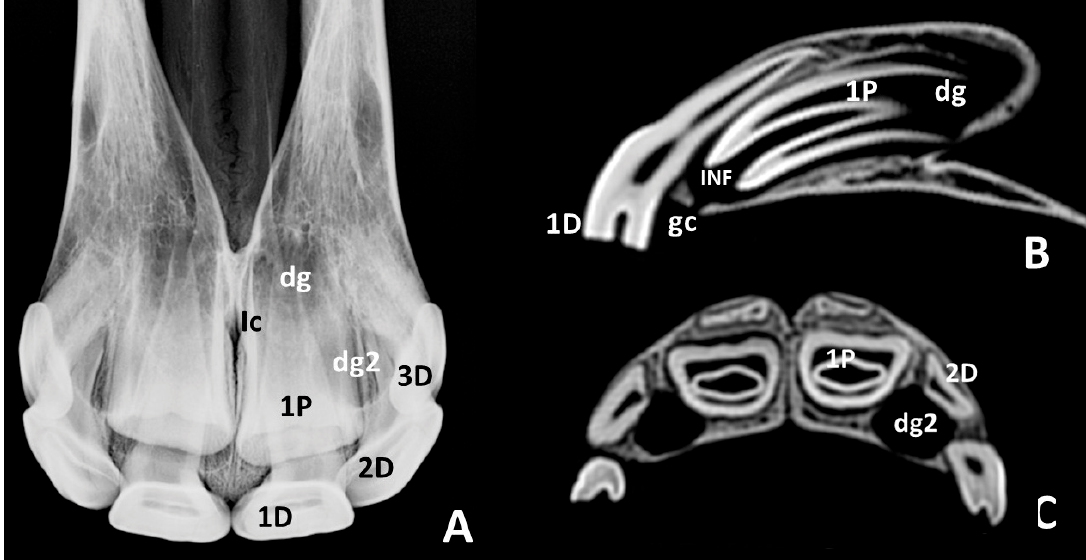
Figure 6. Intraoral radiographic images ( A ) and sagittal and transverse scans ( B , C ) of maxillary incisor arcade of one skull representative of group 1d. 1D , left 1st deciduous incisor—601; 2D , left 2nd deciduous incisor—602; 3D , left 3rd deciduous incisor—603; 1P , unerupted left 1st permanent incisor—201; dg , dental germ of left 1st permanent incisor—201; dg2 , dental germ of left 2nd permanent incisor—202; Gc, gubernacular canal of left 1st permanent incisor—201; Ic , incisive canal; INF